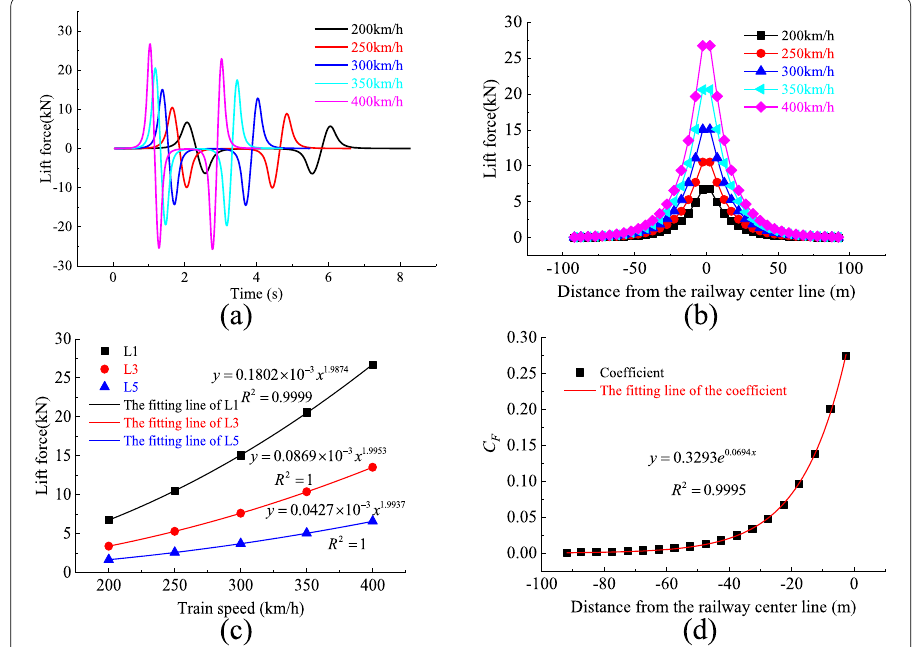
Fig. 7 Effects of train speeds: a lift force time history curve; b attenuation curve of positive lift force of head wave along longitudinal bridge direction; c variation of positive lift force extremum of head wave in L1, L3, L5 with train speed; d head wave lift force positive extremum coefficient along longitudinal bridge